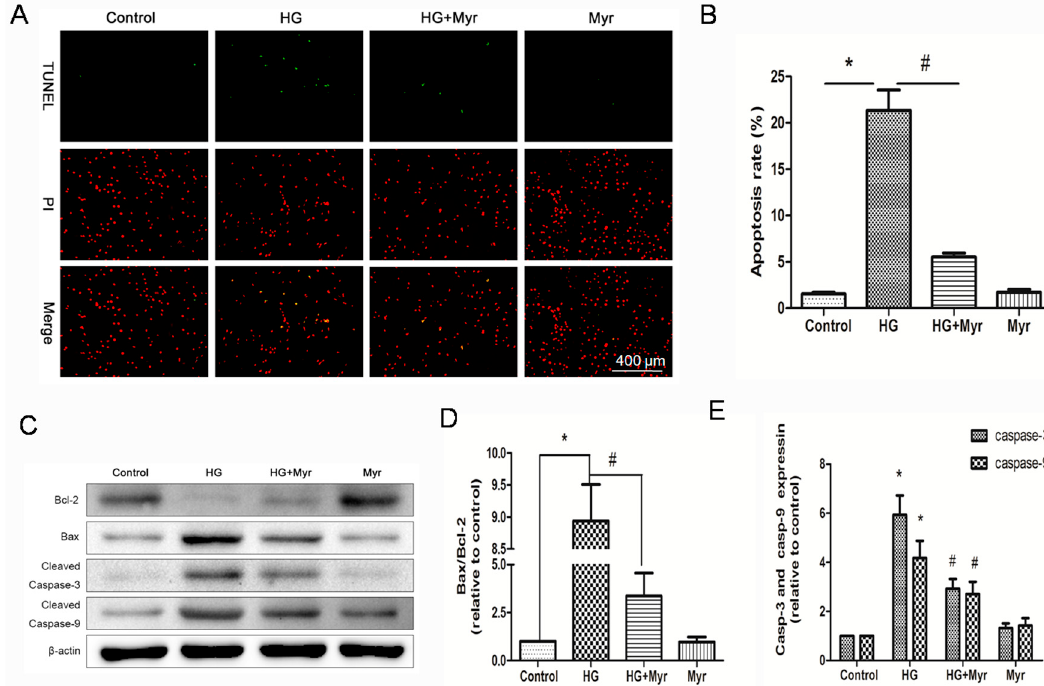
Figure 4. Protection effects of myricitrin against HG-induced H9c2 cells apoptosis. Pretreatment with myricitrin (25 μ g/mL) for 24 h prior to HG, H9c2 cardiomyocytes apoptosis was assessed using TUNEL staining. ( A ) Representative images of TUNEL-positive nuclei in green fluorescent color and total nuclei staining with Propidium iodide (PI); ( B ) Bar diagram showing the relative proportion of TUNEL-positive cells ( n = 5). ( C ) Western blot analysis of cleaved caspase-3, cleaved caspase-9, Bax and Bcl-2 expressions; ( D ) The ratio of Bax to Bcl-2 in various groups; ( E ) Cleaved caspase-3 and caspase-9 expressions in different groups. Values are represented as the mean ± SD ( n = 3). * p < 0.01 vs. control; # p < 0.01 vs. HG.